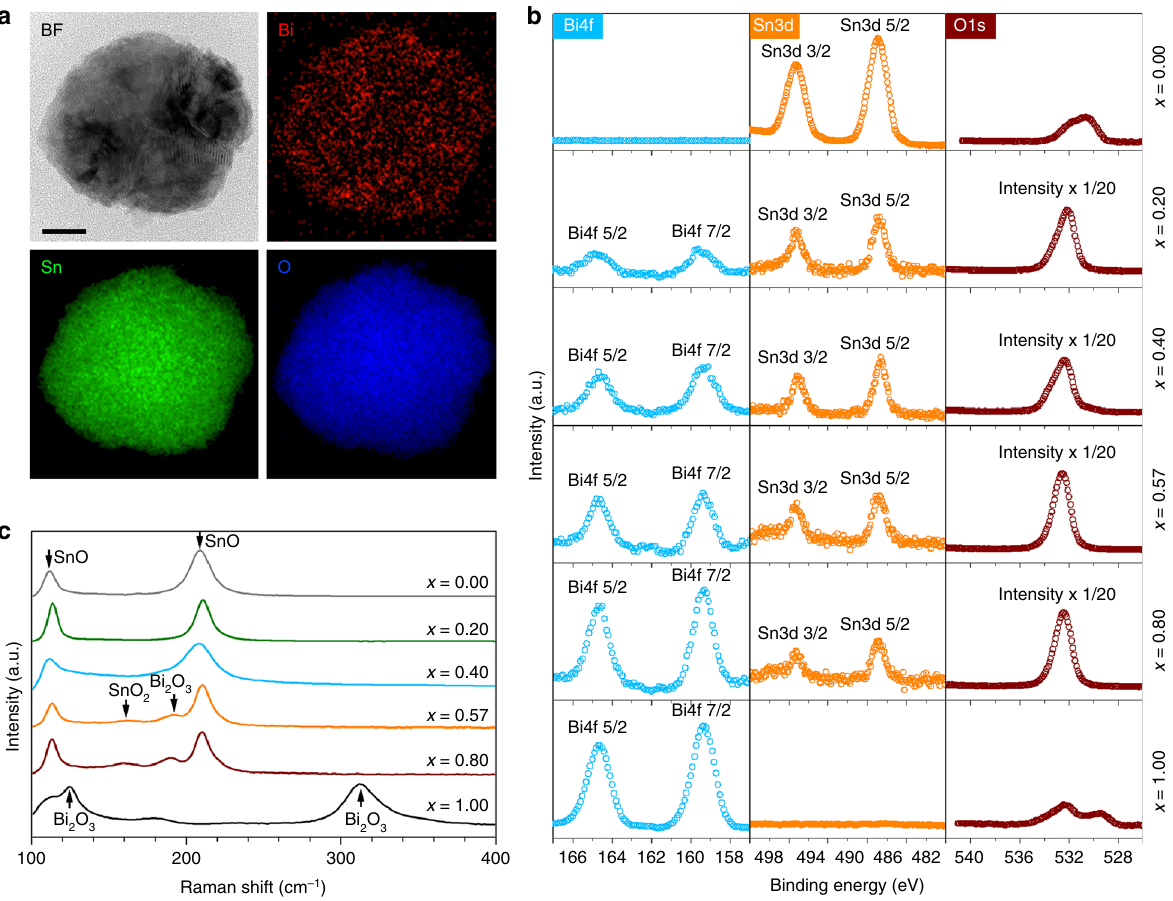
Fig. 4 Surface composition analysis of the Bi x Sn 1- x nano-alloys. a TEM image and STEM – EDX element mapping, showing the distribution of Bi, Sn and O in a eutectic nano-alloy particle. Scale bar: 20 nm. b XPS spectra of different Bi – Sn nano-alloys. The same scale is used for the XPS intensity for different elements of the same sample unless otherwise speci fi ed in the fi gures. c Raman spectra of different Bi – Sn